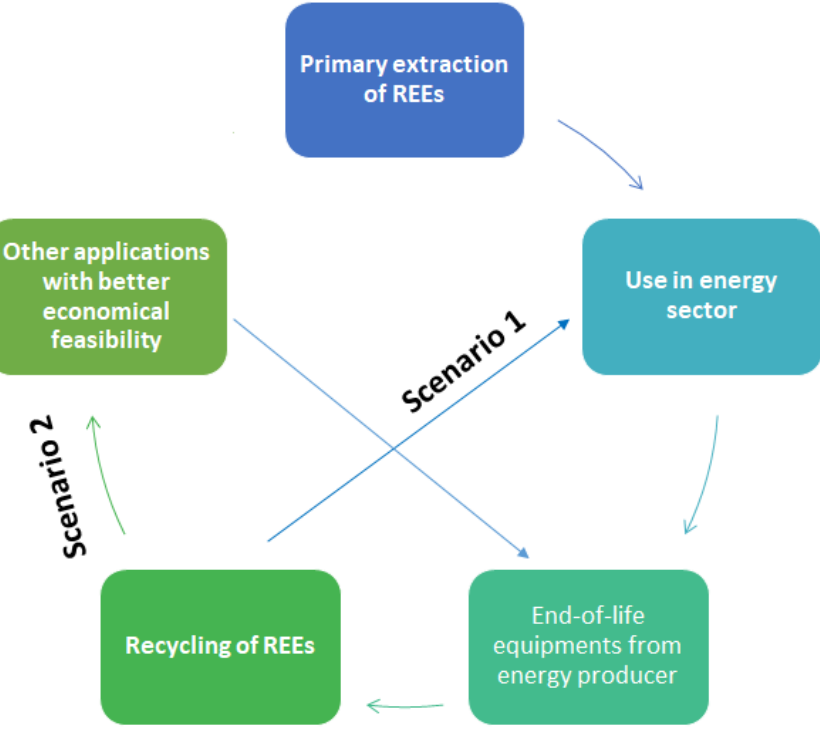
Figure 2. Process cycle of the current study.